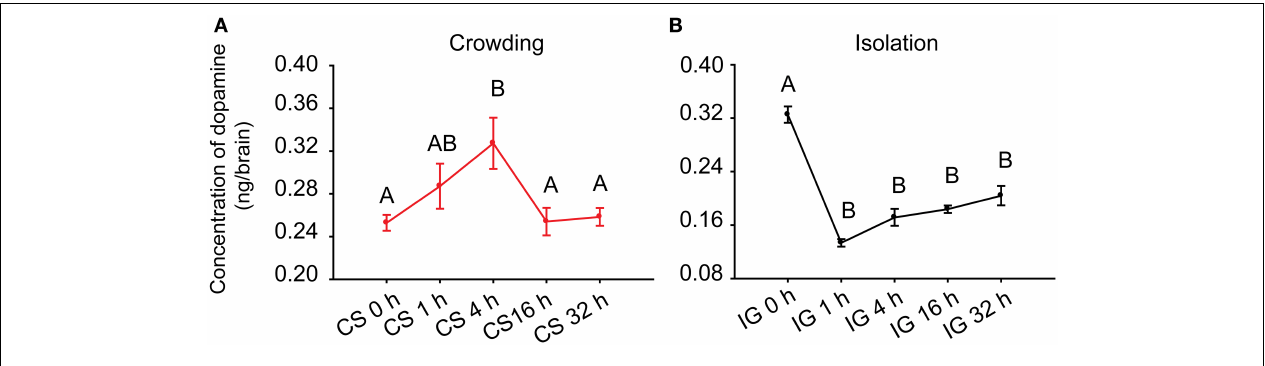
FIGURE 1 | Dopamine levels in the brains of the migratory locust during the time course of crowding and isolation. (A) Concentration of DA in the brains of solitary locusts in the time course of crowding. (B) Concentration of DA in the brains of gregarious locusts in the time course of